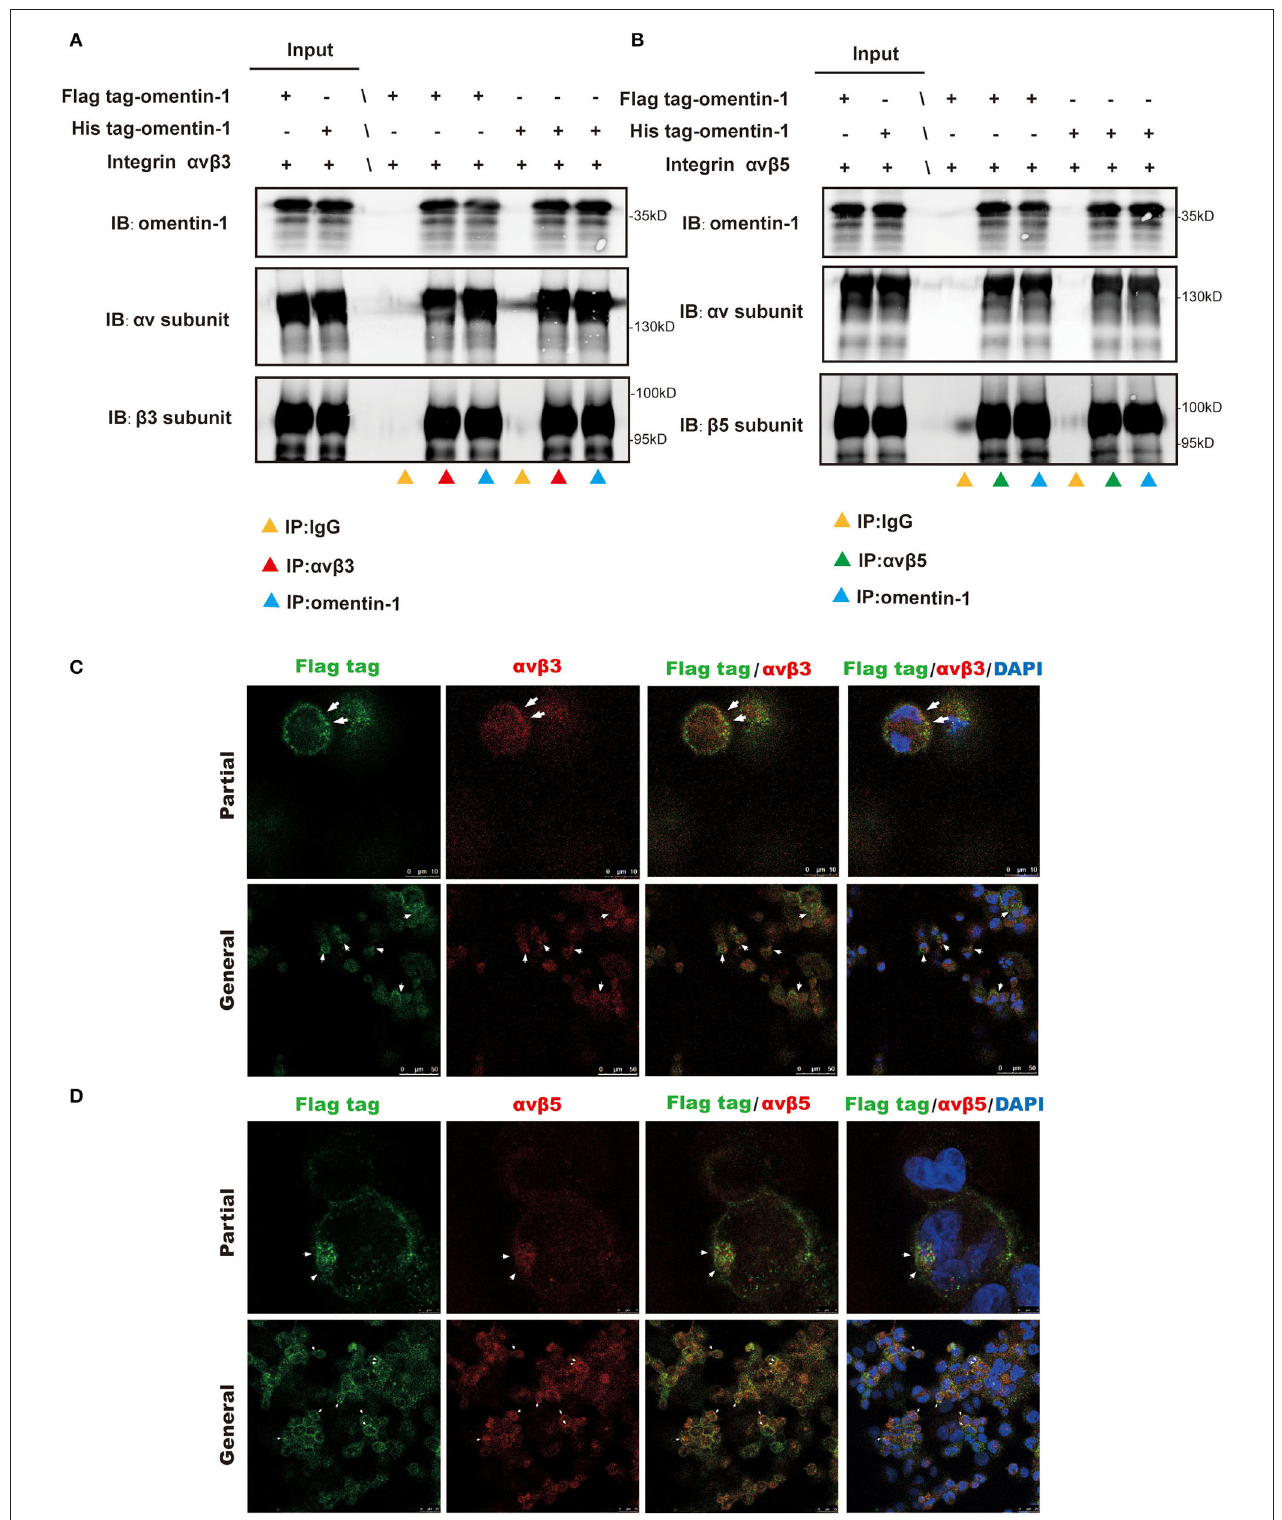
FIGURE 3 | Co-Immunoprecipitation (IP) analysis showed the molecular interaction of omentin-1 (labeled by his tag and flag tag) and integrin α v β 3 and α v β 5. In vitro confocal microscopy demonstrated the spatial co-localization of omentin-1 (labeled by flag tag) and integrin receptors on the surface of THP1-derived macrophages. (A,B) The results of the co-IP analysis of omentin-1 and integrin receptors, α v β 3 and α v β 5. (C,D) In vitro confocal microscopy of exogeneous omentin-1 and integrin receptors. The area where exhibited the co-localization of exogenous omentin-1 (green) and integrin receptors (red) was pointed out by white arrows.